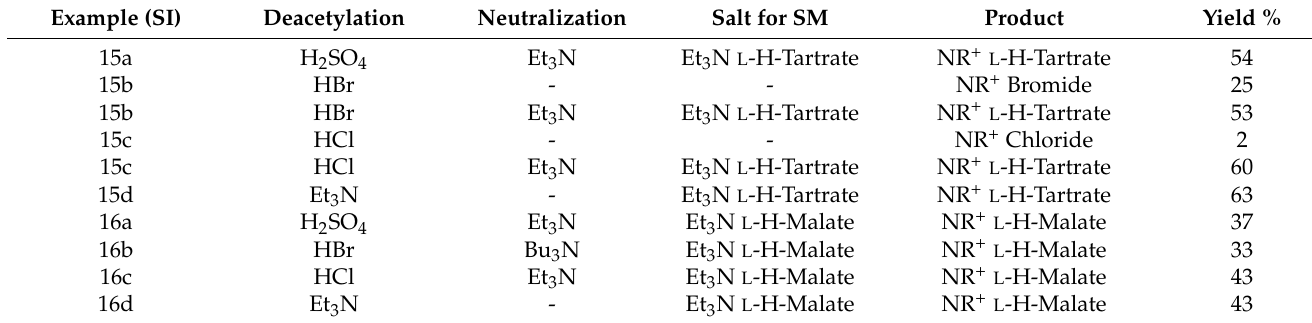
Table 5. Yields of the newly obtained NR salts with various